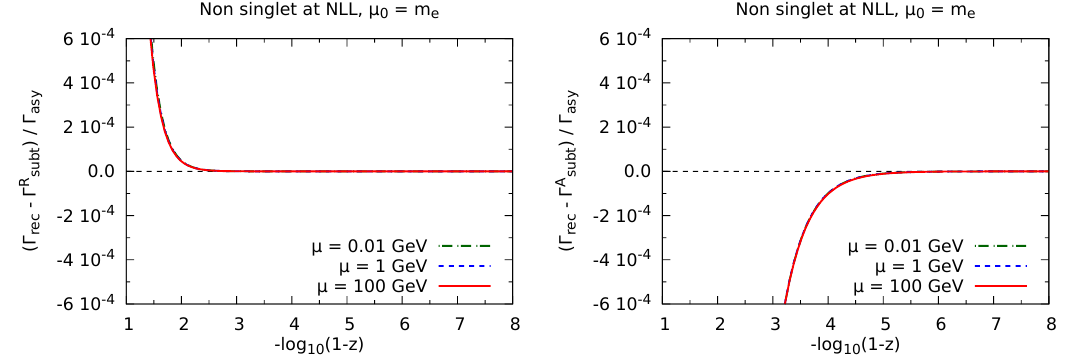
Figure 1 . Ratio of the l.h.s. of eq. (7.8) over its r.h.s. (without the absolute values), for the two choices of the subtraction term (eq. (7.12), left panel; eq. (7.13), right panel), and for three di(cid:11)erent hard-scale values: (cid:22) = 0 : 01 GeV (dot-dashed green), (cid:22) = 1 GeV (dashed blue), and (cid:22) = 100 GeV (solid red). As is indicated, the scale on the y axis of these plots is in units of 10 (cid:0) 4 . similar to those shown here. Apart from being in keeping with the expectations emerging from eqs. (7.16){(7.18), (cid:12)gure 1 shows that, even in the case of eq. (7.12), the